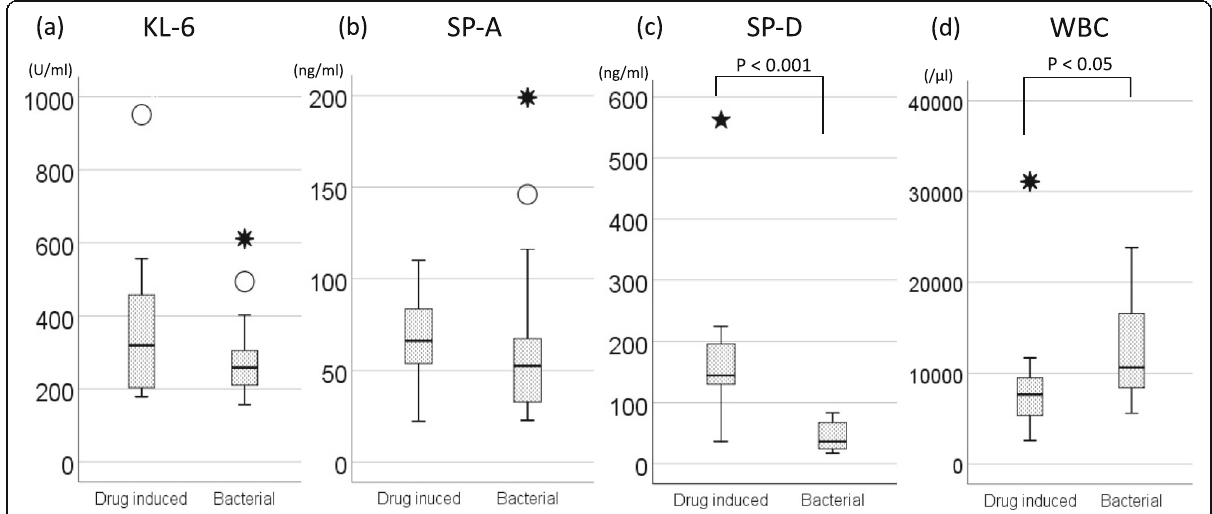
Fig. 1 Comparison of serum biomarker and WBC levels between a drug induced group and bacterial pneumonia group. There was no significant correlation between d-pneumonia and b-pneumonia with regard to KL-6 ( a ) and SP-A ( b ) levels. However, SP-D ( c ) and WBC ( d ) levels showed a significant correlation ( P < 0.001, P < 0.05). In the box plots, the boundary of the box closest to zero indicates the 25th percentile, a black line within the box marks the median, and the boundary of the box farthest from zero indicates the 75th percentile. Whiskers above and below the box indicate the 10th and 90th percentiles. Points above and below the whiskers indicate outliers outside the 10th and 90th percentiles. The dotted line indicates the cut off value. KL-6, Krebs von den Lungen-6; SP, Surfactant protein; WBC, White blood